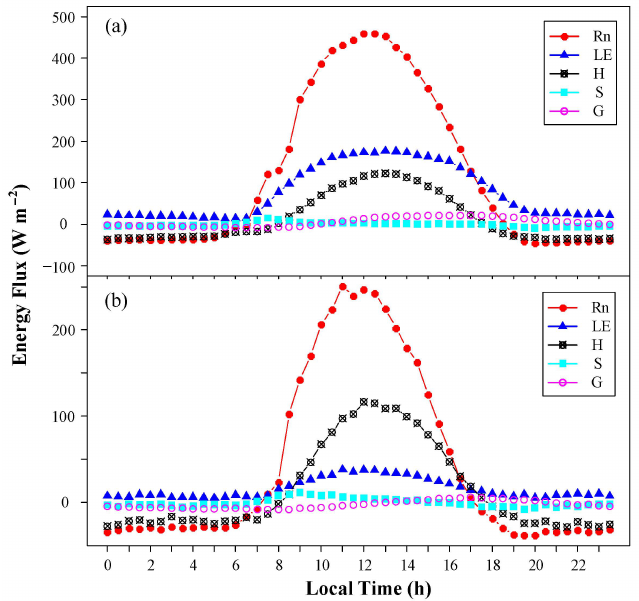
Figure 7. Mean daily variation in energy fluxes during the ( a ) growing season and ( b ) dormant